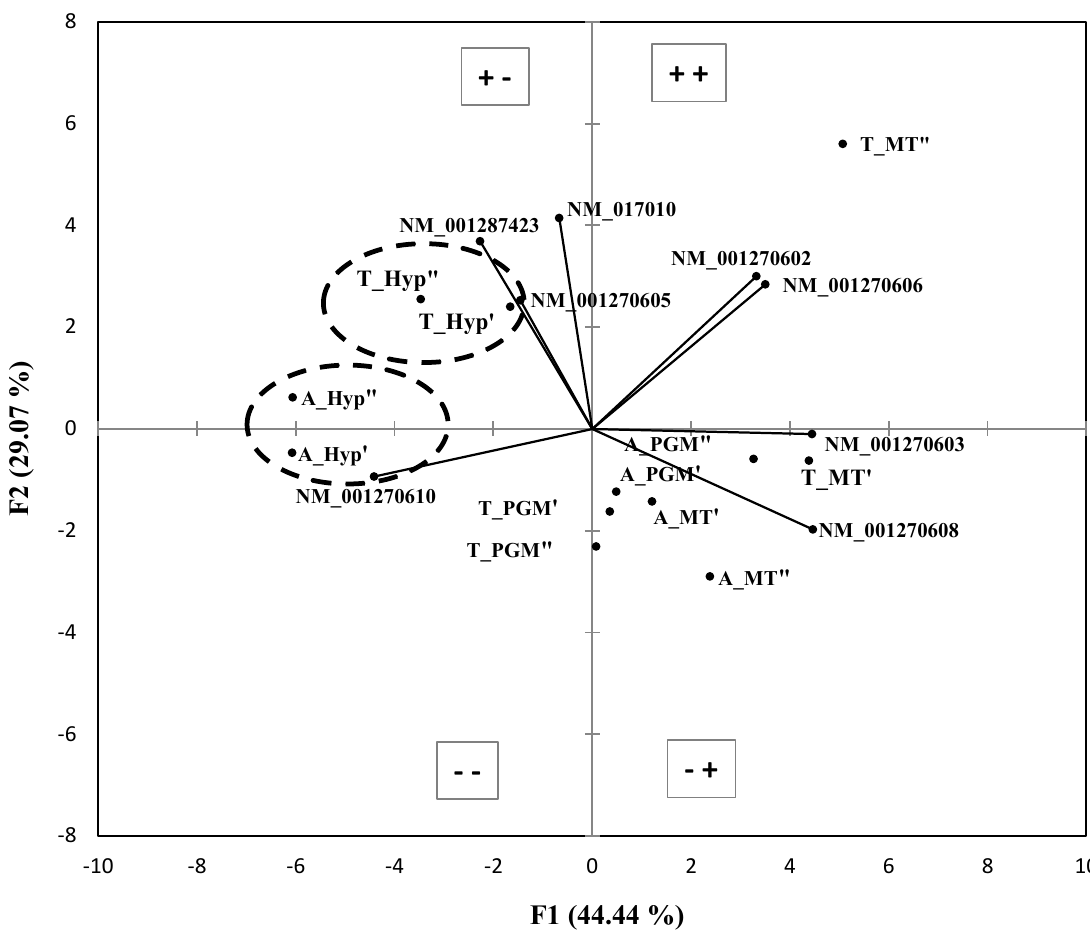
Figure 3: Isoforms expressions vectors and location of samples in Principal Components. Bracketed sign pairs (+-), (++), (-+), (--) correspond to exon 21 and 5, correspondingly; «-» denotes to absence and «+» - correspond to presence in mRNA. «A_» and «T_» prefixes designate aggressive and tame rat samples,